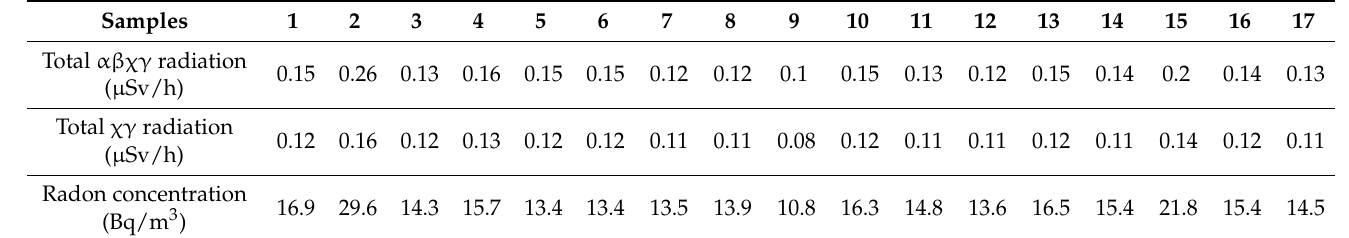
Table 2. Measurement of radioactive absorbed dose rate of tailing yard in 17 mining